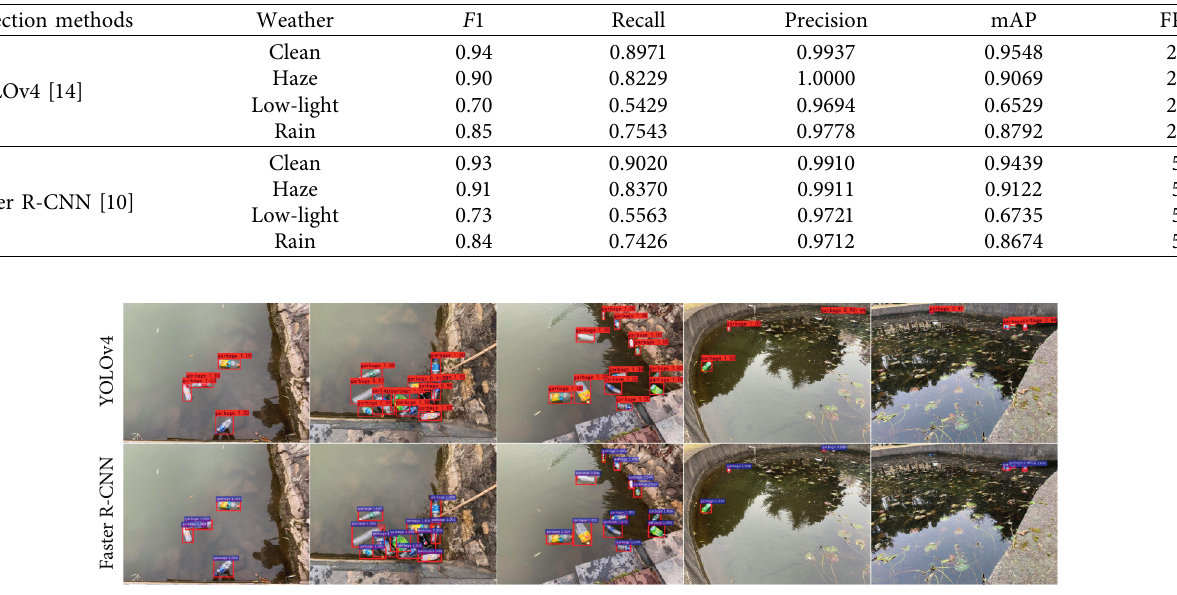
Figure 4: The water-surface garbage detection results under normal light conditions. Both YOLOv4 and Faster R-CNN are capable of generating satisfactory detection performance. In contrast, Faster R-CNN only fails to implement small-scale target detection.